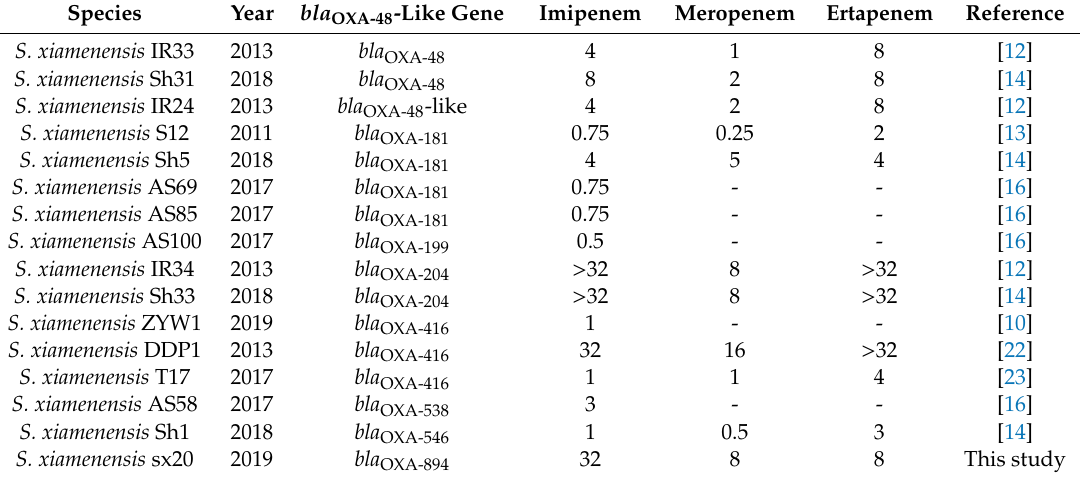
Table 1. The carbapenem MICs (mg / L) of S. xiamenensis harboring bla OXA-48 -like